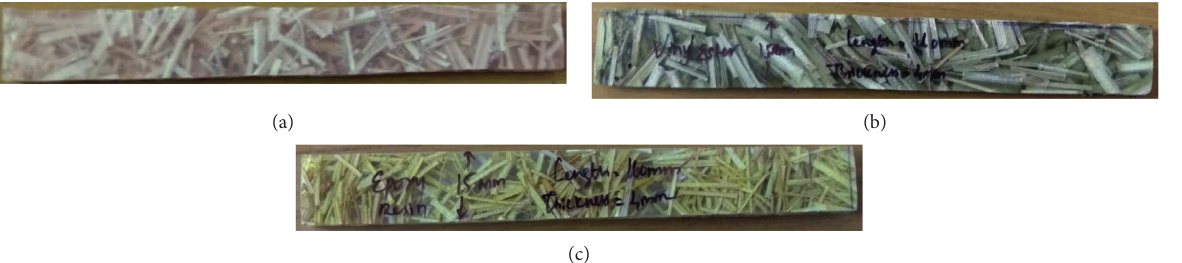
Figure 4: Palmyra sprout fiber-reinforced (a) polyester, (b) vinyl ester, and (c) epoxy composites